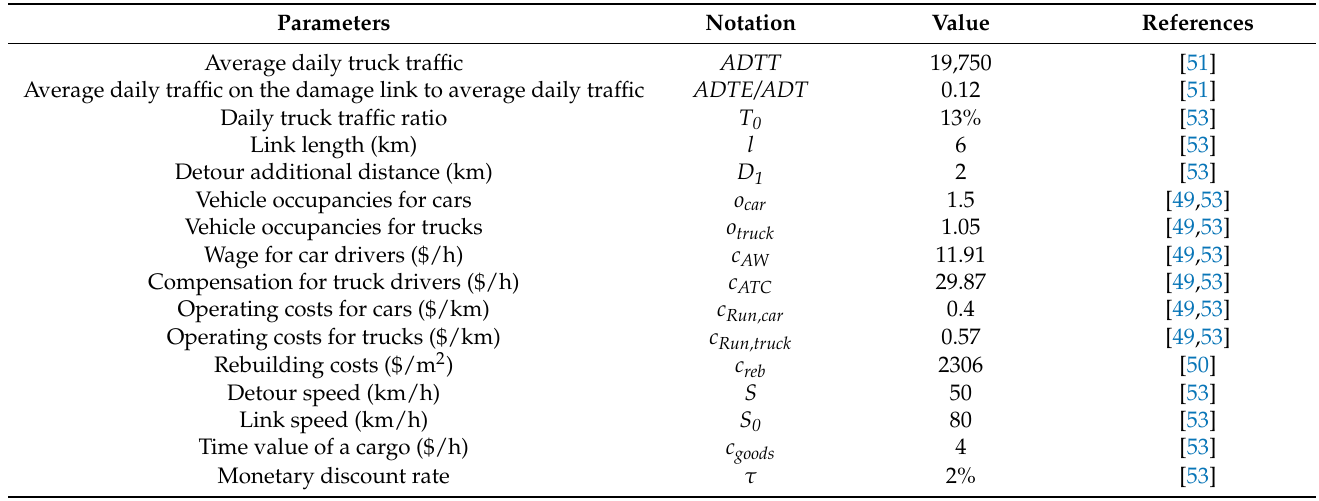
Table 1. Parameters associated with